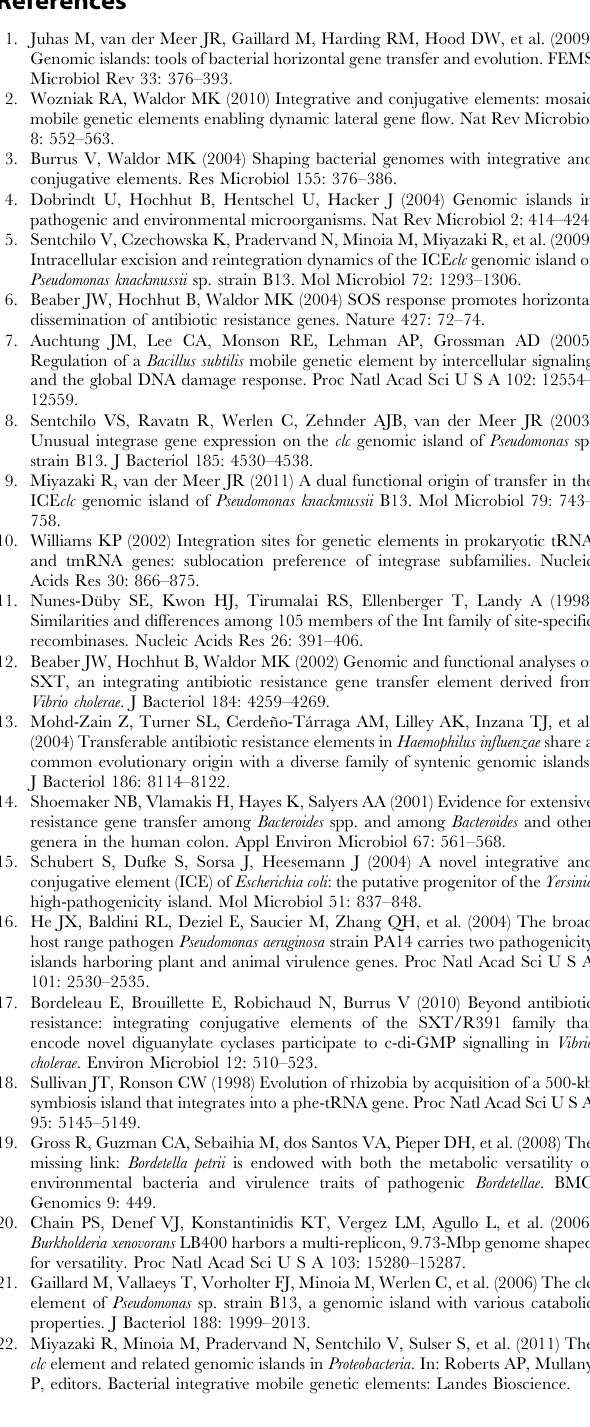
Table S4 Primers used in this study.